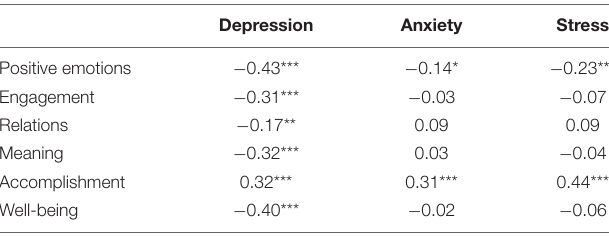
TABLE 3 | Partial correlations between the results of the DASS and PERMA scales when controlling for psychological